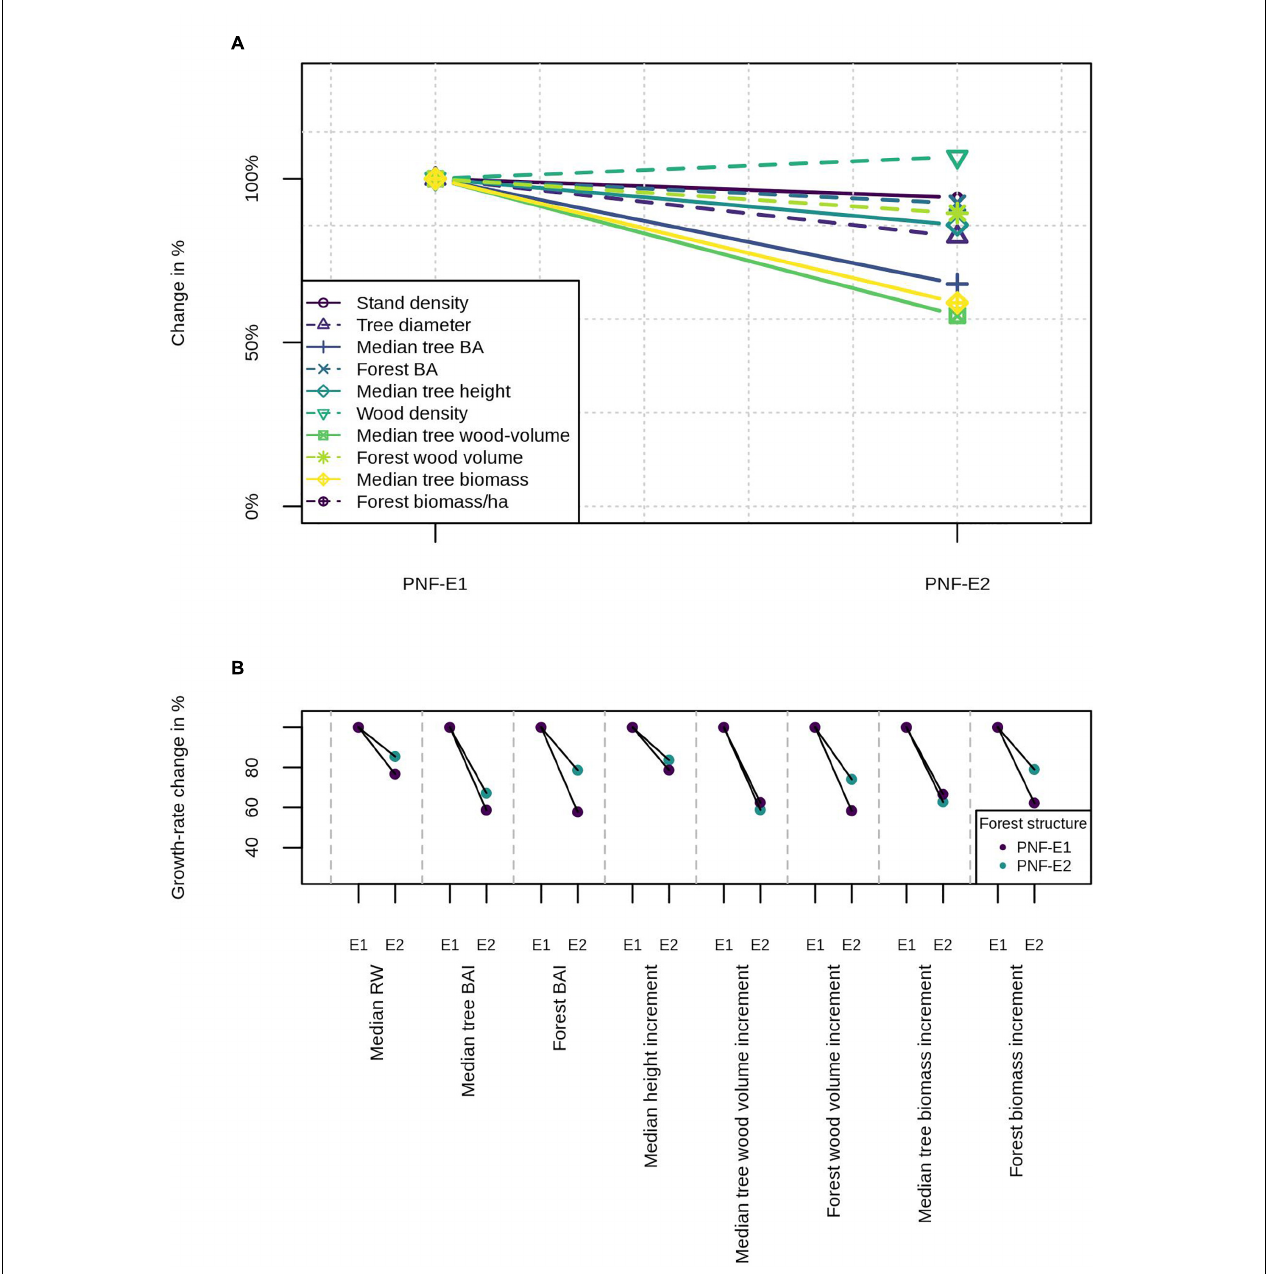
FIGURE 4 | Example of two forests PNF-E1 and PNF-E2 that developed under their respective environments E1 and E2. Both forests differ in their structural parameters (A) . When PNF-E1 is exposed to E2, it will slowly adapt and turn into PNF-E2. However, without time for adaptation the growth rates will differ (B) . Structural overshoot and a stand density above the carrying capacity result in lower growth rates of a forest that is not adapted to